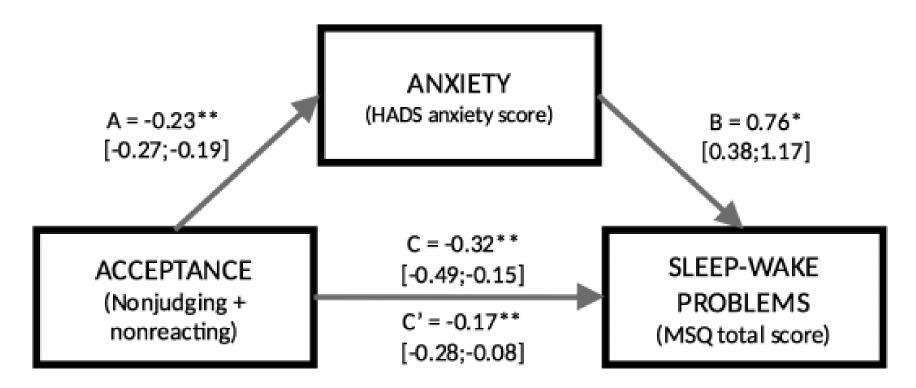
Figure 2. The metric invariance model with all estimated parameters. * p < 0.05, ** p <